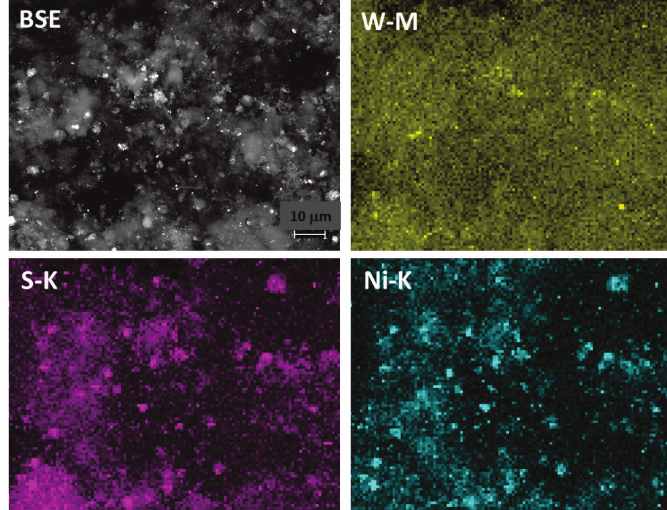
Figure 5. Phase distribution studied by SEM/EDX analysis. Top left : Backscattered electron image showing the carbon fibers in grey and the metal containing phases as bright spots in the sample CNF/IF-WS with the lowest IF-WS loading. Elemental mapping by 2 2 EDX analysis confirmed the presence of IF-WS mainly as highly dispersed phase 2 ( top right ) with small (nm) particle size. The elemental Ni map shows the presence of nm and micron size particulates ( bottom right ). The sulfur map ( bottom left ) includes both, the IF-WS and Ni sulfide 2